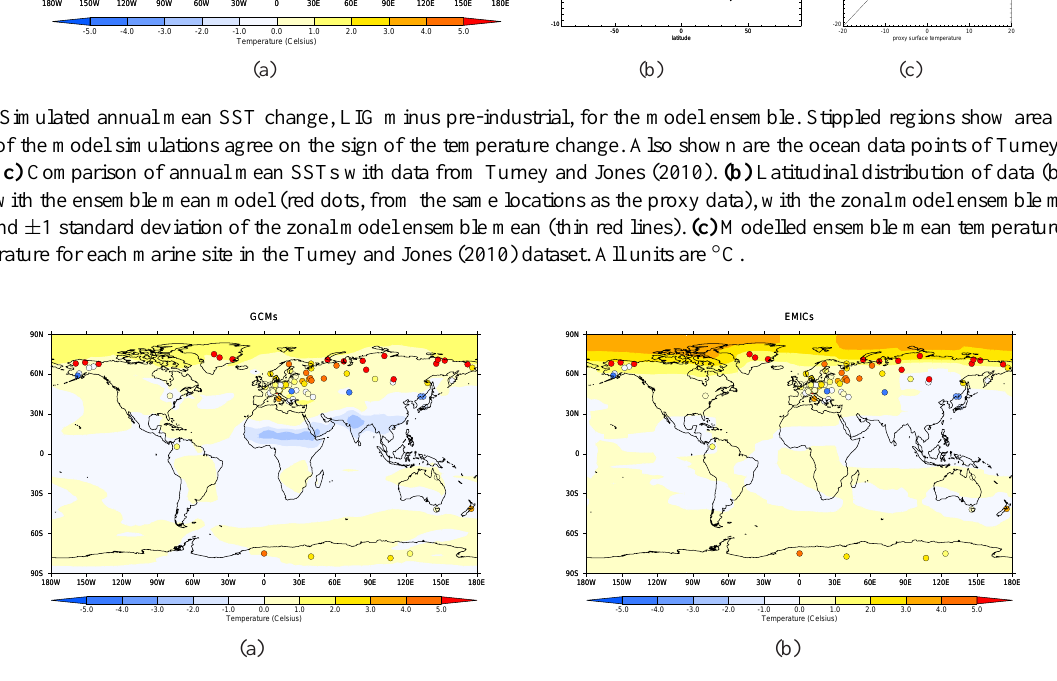
Fig. 10. Simulated surface air temperature change, LIG minus pre-industrial, for (a) the GCMs in the ensemble, (b) the EMICs in the ensemble. Also shown are the terrestrial data points of Turney and Jones